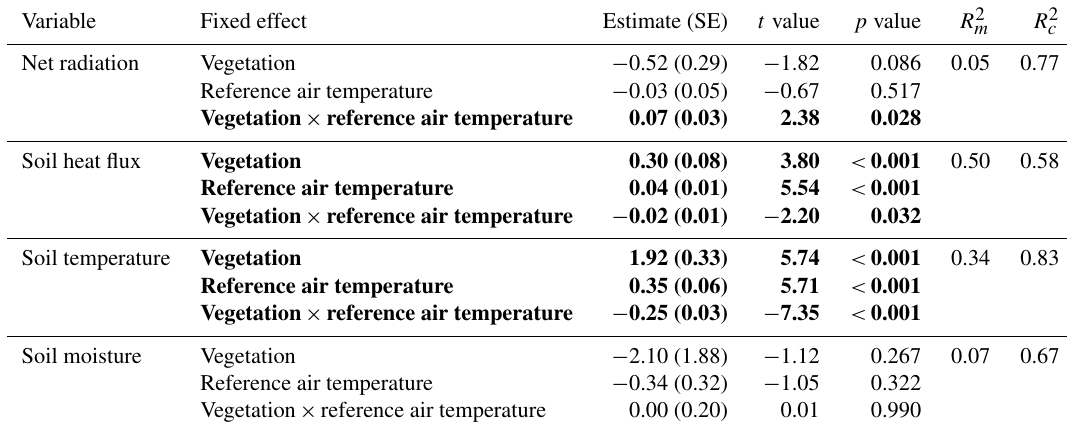
Table C2. Results of the linear mixed models for the effect of vegetation type and air temperature on the nighttime total net radiation, the nighttime total soil heat flux, the nighttime average soil temperature and the nighttime average soil moisture. Statistically significant effects ( p< 0 . 05) are indicated in bold. R 2 m indicates the variation explained by the fixed effects, and R 2 c indicates the variation explained by the entire model. See Fig. 7 for a visualization of the